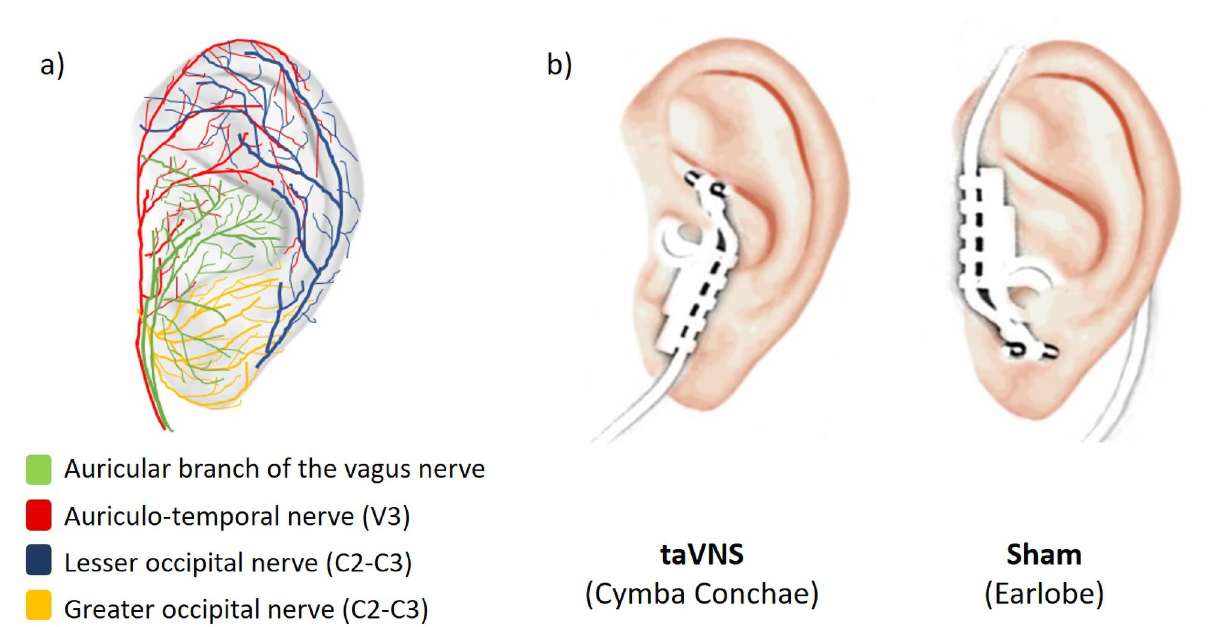
Fig 1. Auricular stimulation. a) Auricular ear anatomy. b) Electrode positions for taVNS and sham conditions, on the left ear. Stimulations parameters were identical between both conditions, consisting of monophasic rectangular impulses at 25Hz and 250 μ s pulse width, with a duty cycle of 30s ON /30s OFF. Current intensity (mA) was titrated at individual level to elicit a maximal, but non-painful, tingling sensation. Abbreviations : V3 : Third branch of the trigeminal nerve (mandibular branch) . C2 and C3 : Second and Third cervical roots of the cervical plexus . Adapted from Peuker & Filler (2002) , He et al (2012) .